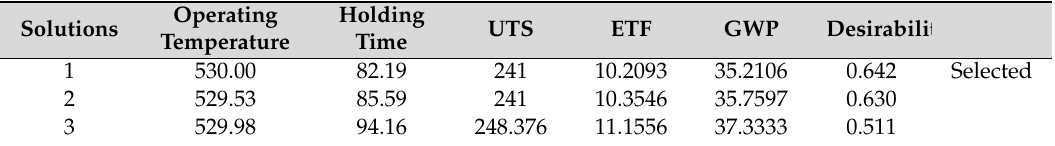
Table 12. Suggested solution for optimum responses.